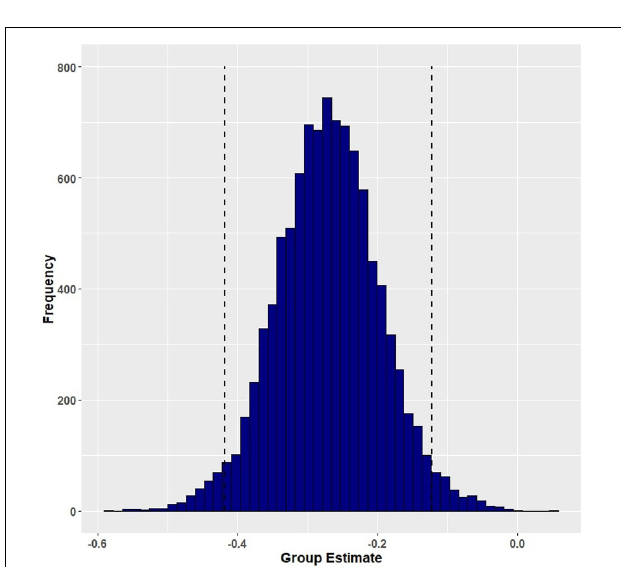
FIGURE 2 | Posterior distribution and 95% highest density intervals of the interaction effect of group and event-related facilitation from Model 1 (primed accuracy for participants with aphasia and healthy controls). Dashed lines mark the 95% highest density intervals (HDIs) for the posterior distribution.